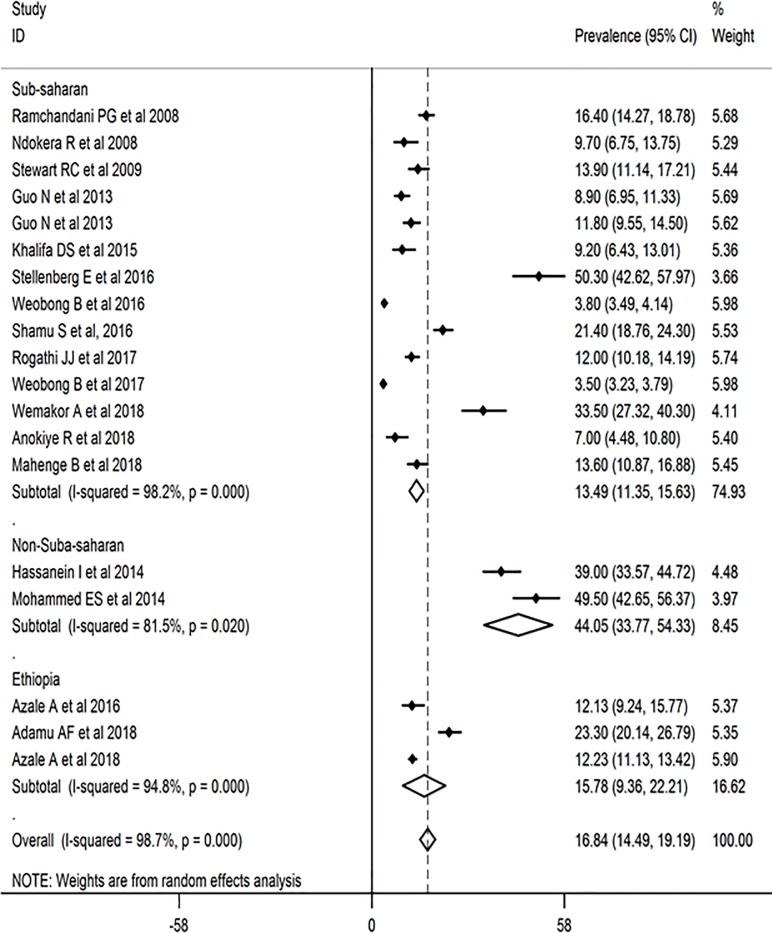
Postnatal depression prevalence in Africa, a meta-analysis, sub analyzed by geographical area (N = 19, random effect).